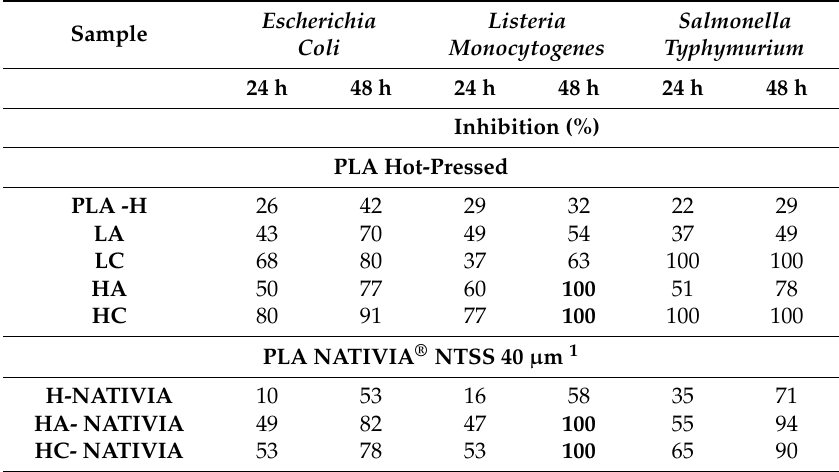
Table 4. Results of the antibacterial tests performed according to ISO